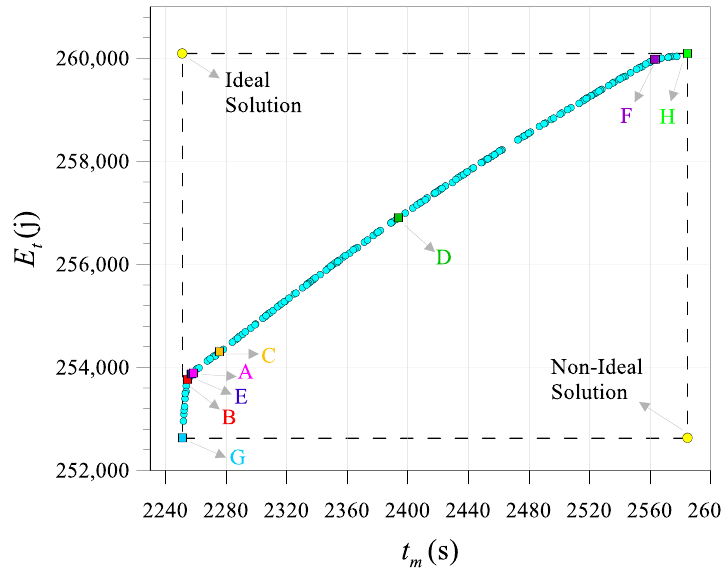
Figure 12. Location of selected solutions on the Pareto front. Table 6. Comparison of the selected optimal points. Table 7. Deviation index for MCDM methods.